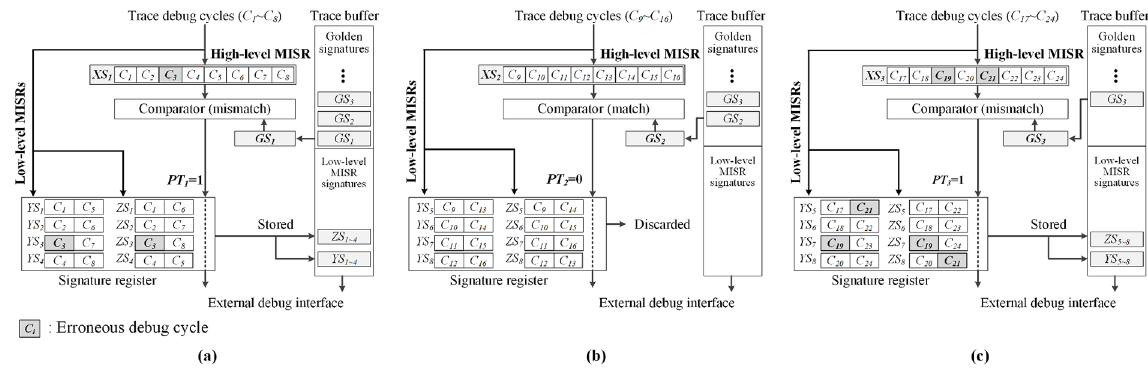
Fig 3. Hierarchical MISR operation: (a) and (c) cases of PT i = 1; (b) case of PT i = 0.